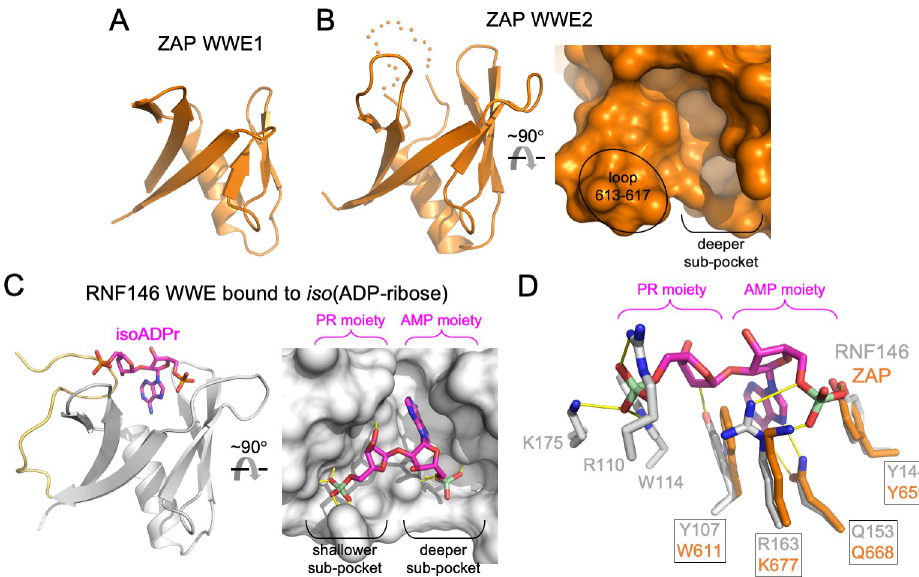
Fig 3. Structural analysis of the ZAP WWE modules. (A) Structure of ZAP WWE1. (B) Structure of ZAP WWE2 in ribbons (left) and surface representation (right). Relevant features are labeled. (C) Structure of RNF146 WWE with bound isoADPr ligand (PDB 3V3L) [11]. Left shows the protein in ribbons (gray with the C-terminal extension in yellow) and the ligand in sticks (magenta). Right shows the protein in surface representation. Relevant features are labeled. (D) View of pocket residues in the same orientation as the ribbons in B and C, after backbone-guided superposition of ZAP WWE2 (orange) and RNF146 WWE (gray) with bound isoADPr (magenta). Residues with structural equivalents in ZAP and RNF146 are boxed; residues with no equivalents are unboxed. Hydrogen bonds are shown in yellow.